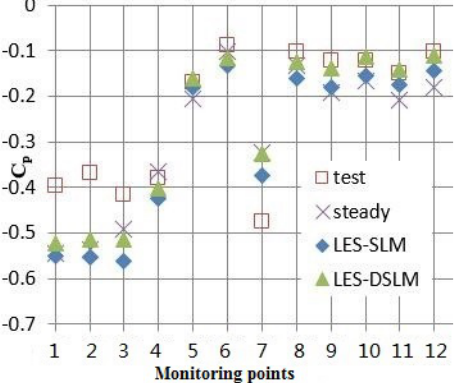
Figure 15. Pressure contour obtained using the DSLM method at t = 0.765 s.